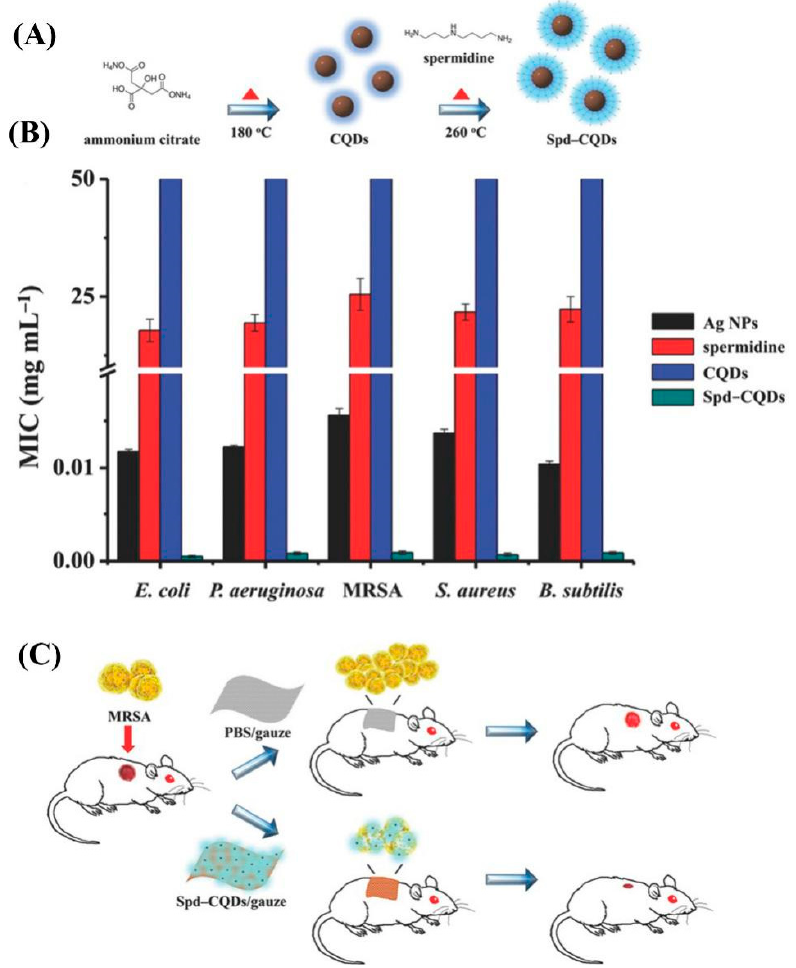
Figure 6. ( A ) Schematic illustration of the preparation of spermidine-functionalized carbon quantum dots (Spd–CQDs) from ammonium citrate and spermidine. ( B ) Minimum inhibitory concentrations (MICs) of silver nanoparticles (Ag NPs), spermidine, CQDs, and Spd–CQDs against five strains of bacteria. ( C ) Schematic presentation of the use of Spd–CQDs for wound healing. MRSA, methicillin- resistant S . aureus . Reproduced with permission from [73]. Copyright Wiley, 2016.